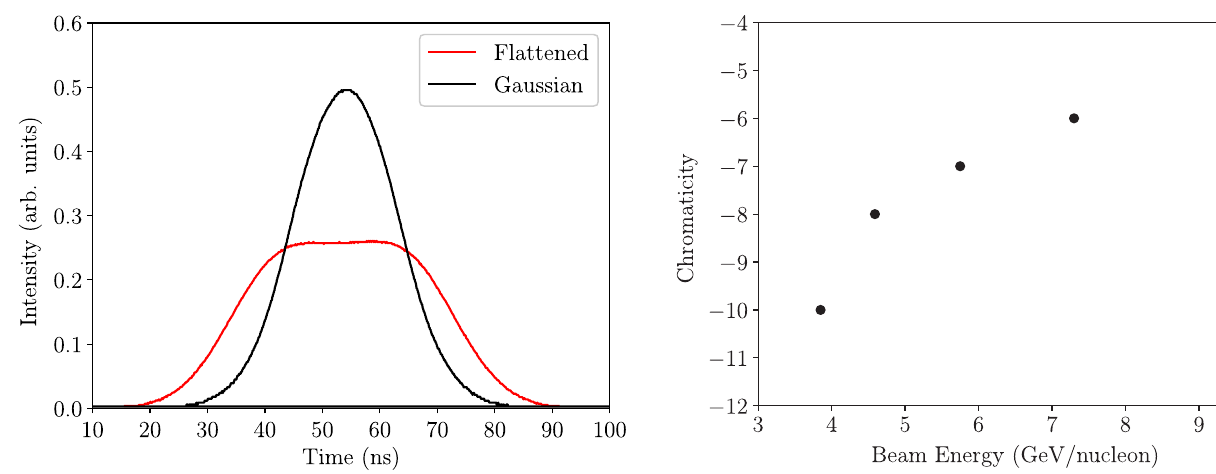
FIG. 13. Gaussian longitudinal profile (the black curve) for a single rf system and flattened longitudinal profile (the red curve) for a double rf system, with the third harmonic cavities phased opposite to the primary rf.